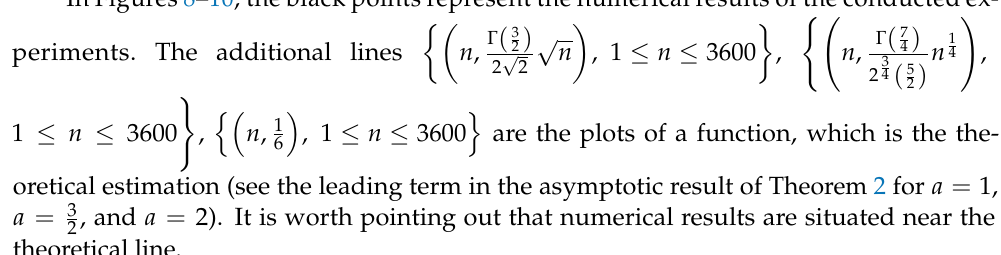
( 1 ) = Θ ( 1 ) of Algorithm 4. n